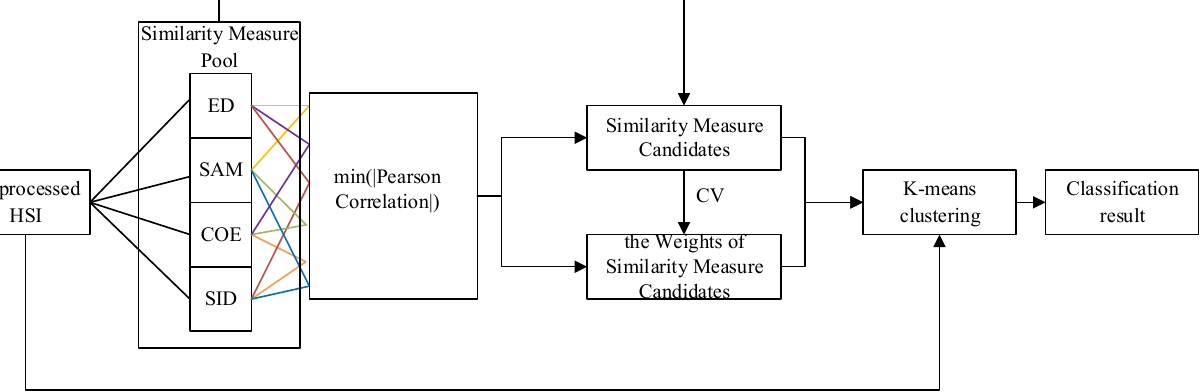
Figure 4. The evaluation scheme for the HCW-SSC method (Euclidean distance (ED), spectral angle cosine (SAC), spectral correlation coefficient (SCC), and spectral information divergence (SID)).